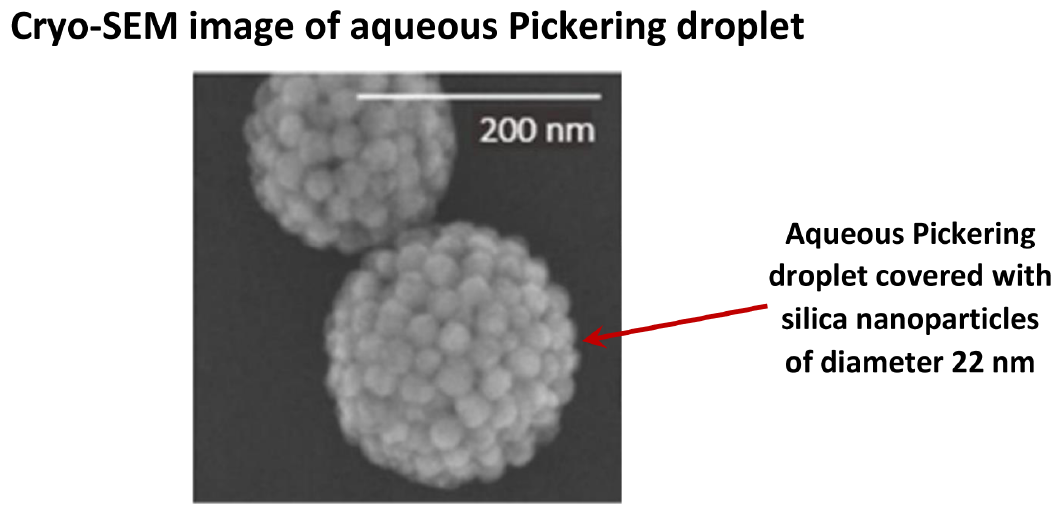
Figure 2. A cryo-scanning electron microscopy (cryo-SEM) image of droplet of W/O Pickering emulsion (Adapted with permission from [35]).